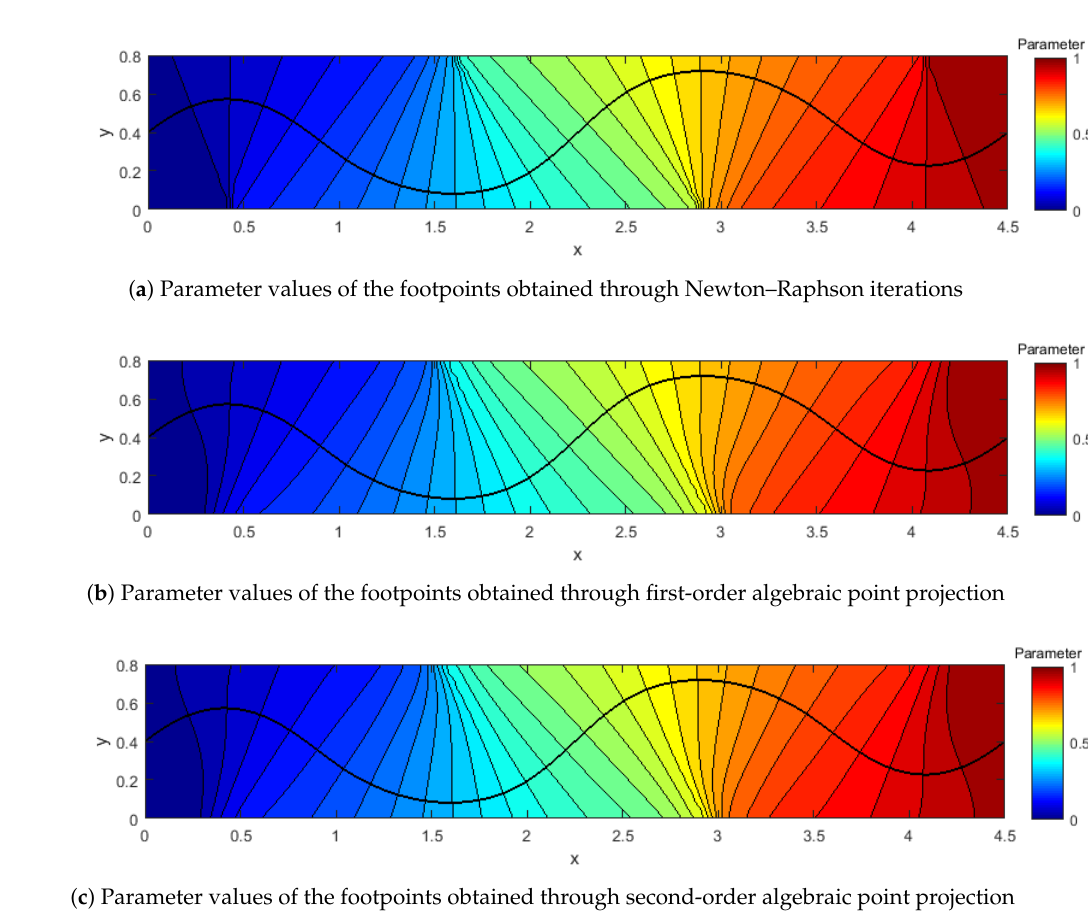
Figure 16. Parameter values of footpoints obtained using: ( a ) Newton–Raphson method; ( b ) first-order algebraic point projection; and ( c ) second-order algebraic point projection. Parameter range of NURBS curve is [ 0,1 ]